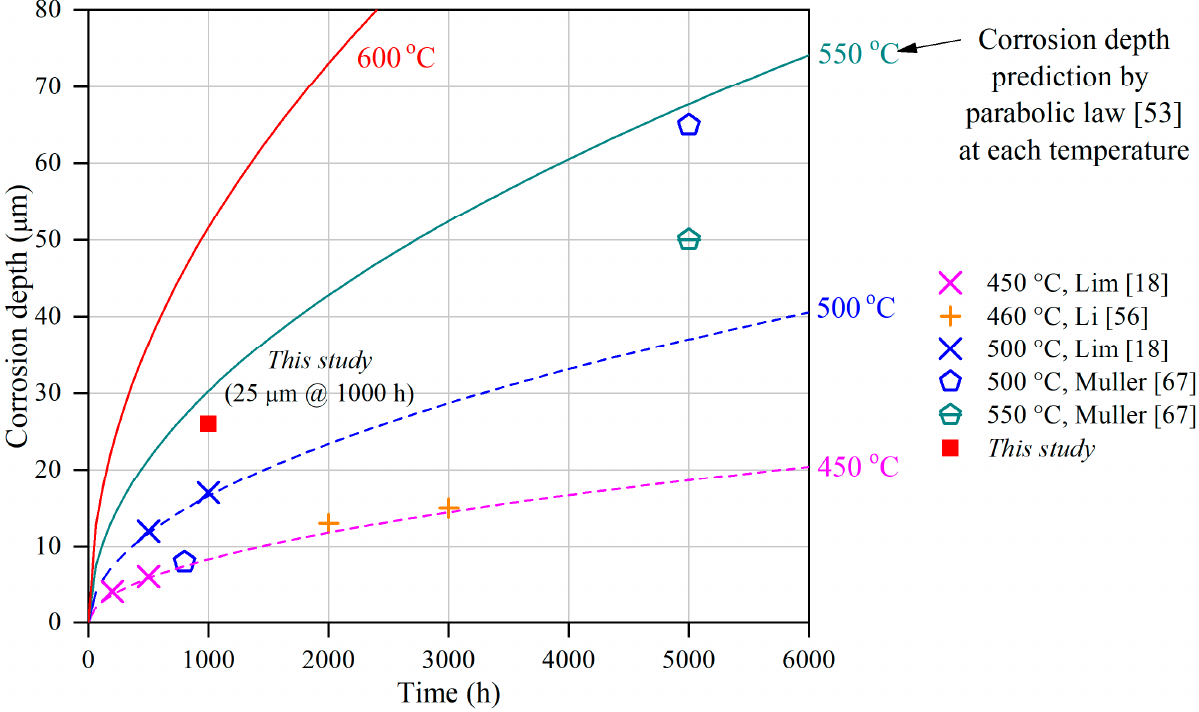
Figure 16. Prediction of the corrosion depths on HT9 [18,53,56,67].